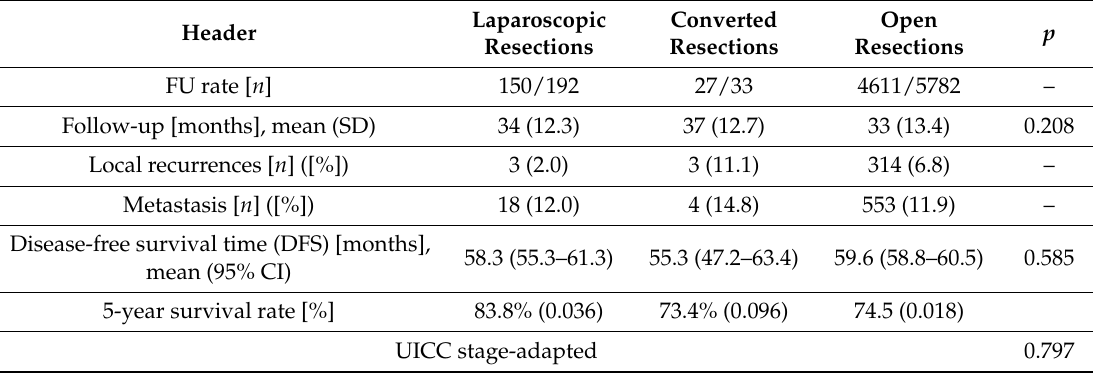
Table 4. Comparison of long-term results for RC after laparoscopic versus open rectal resection (Ptok et al. 2006 [104]).